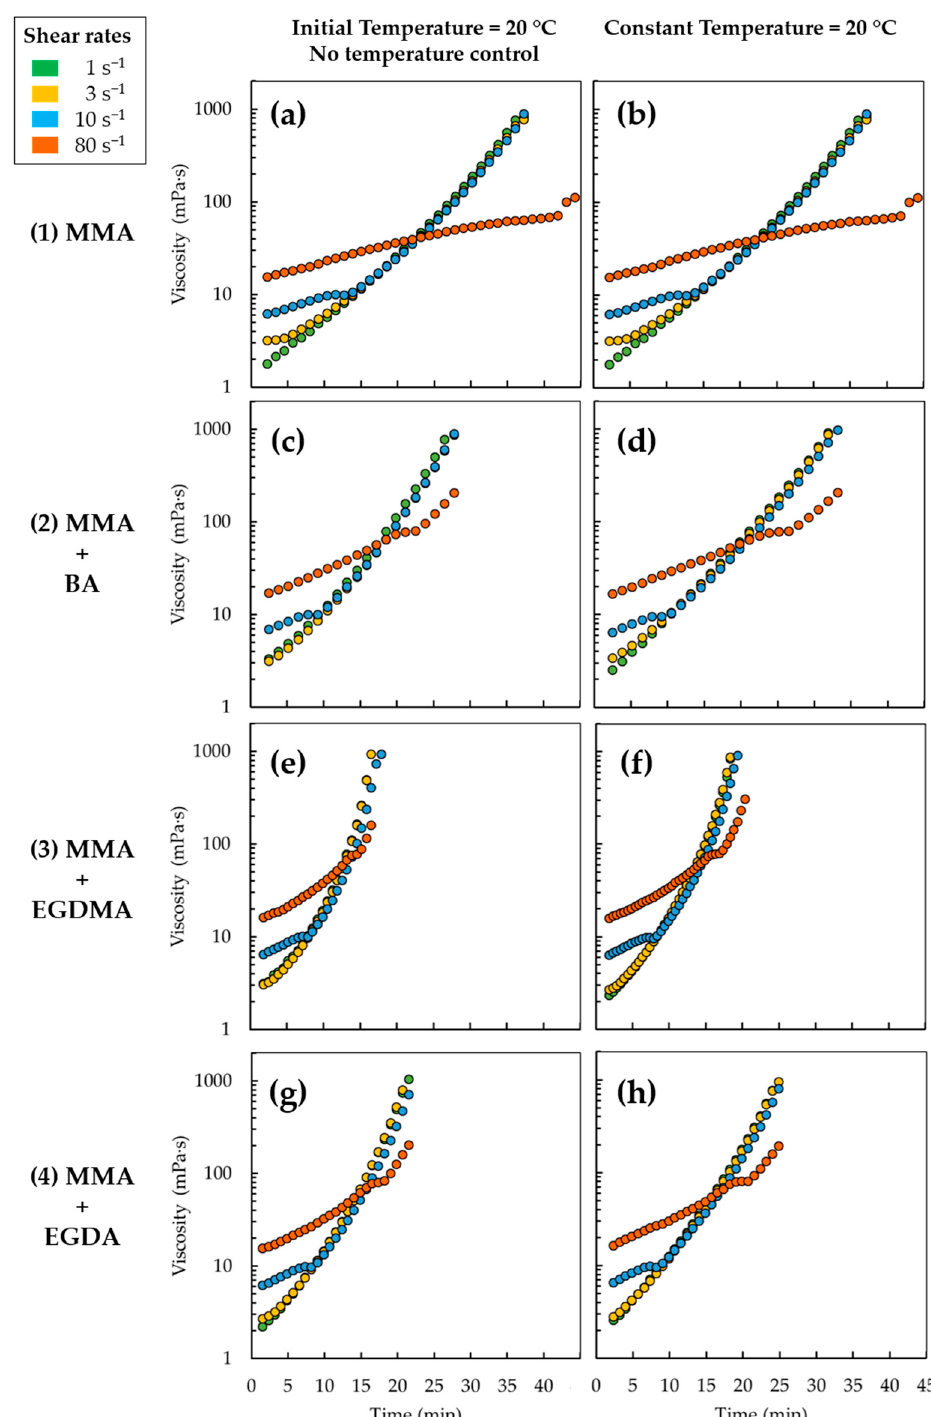
Figure 6. Curves of viscosity versus reaction time at four shear rates (1 s − 1 in green, 3 s − 1 in yellow, 10 s − 1 in blue, and 80 s − 1 in orange), for four coformulations (from top to bottom) ( 1 ) MMA (subplots ( a ) and ( b )), ( 2 ) MMA + BA (9:1) (subplots ( c ) and ( d )), ( 3 ) MMA + EGDMA (98:2) (subplots ( e ) and ( f )), ( 4 ) MMA + EGDA (98:2) (subplots ( g ) and ( h )) (Cases 3, 5, 7, and 9 in Table 1). Every test case was evaluated under two types of conditions: initial temperature of 20 °C followed by no temperature control (left column), and constant temperature of 20 °C (right column). All data are reported after the application of protocol in Figure 2.